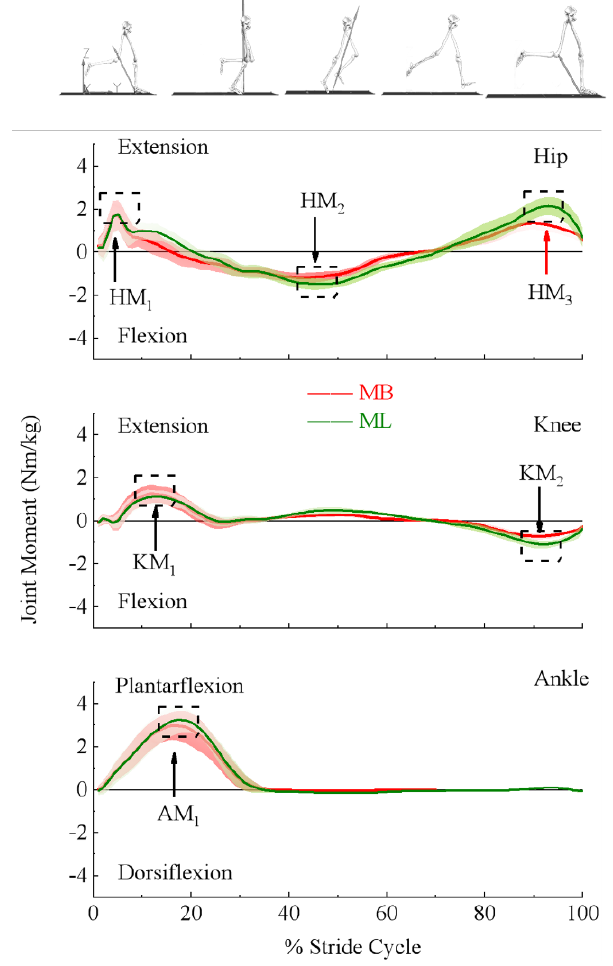
Figure 1. Labeled here are the outcome variables used to quantify the differences in the lower extremity joint moments of the hip (top panel), knee (middle panel), and ankle (bottom panel) (denoted under the ensemble moment curve estimated by marker-based (MB) (red) and markerless (ML) (green) motion capture systems). Joint moments were scaled to participants’ body